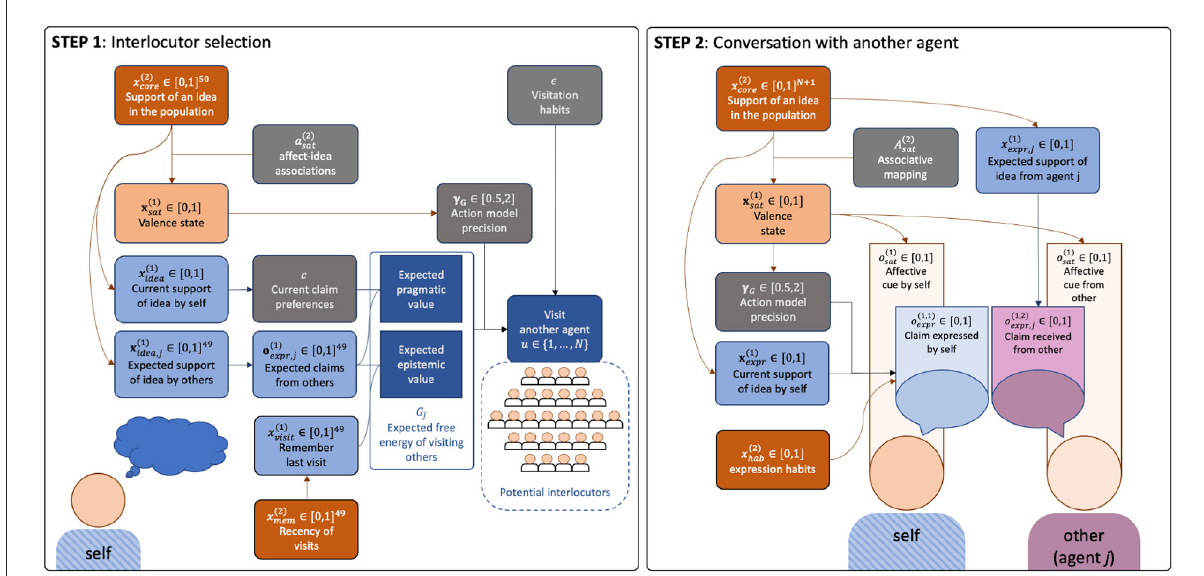
FIGURE7 A diagram illustrating the steps of the generative model. (Left) Lower level Step 1: Interlocutor selection. Each day, each agent selects one interaction partner (selecting themselves means staying home). Agents cannot see each other’s “opinion” before conversing. Meeting selection was conditioned on: (1) Habitual visitation drives, depending on past actions. (2) Deliberate drives, conditioned on: (2a) Expected (mis)match between expressed opinions (pragmatic value) and (2a) expected reduction in uncertainty about opinions of other agents, depending on one’s memory of recent visits (epistemic value). (Right) Lower level Step 2: Conversation with a selected agent. Each meeting consisted in exchanges of expressed support for an idea [in the range (0,1)] and affective cues [negative-positive, in the range (0,1)]. Expressed support was conditioned on: (1) Expression habits formed during past conversations, (2) one’s current support for the idea. Expressed affective cues were conditioned on one’s current valence state. Affect played a role during Steps 1 and 2: Relative reliance on habitual tendencies vs. deliberation (expected free energy G ) was regulated via action model precision. The latter was conditioned on one’s current valence state, which was conditioned on one’s current support of an idea, depending on previously learned associations between expressed ideas and concurrent affective cues (from oneself and